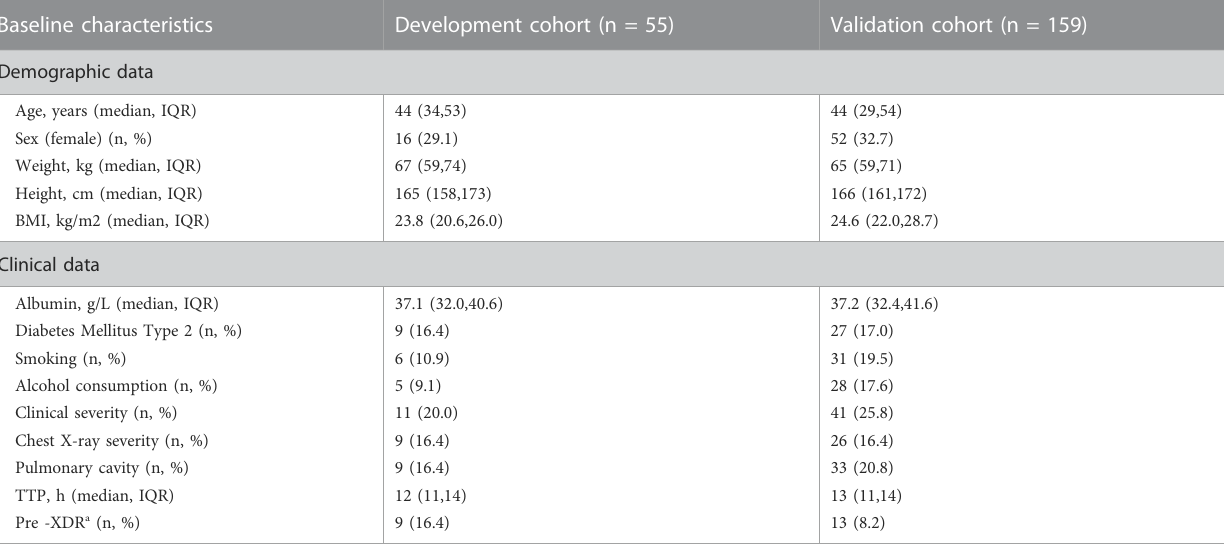
TABLE 1 Baseline demographic and clinical characteristics of subjects.